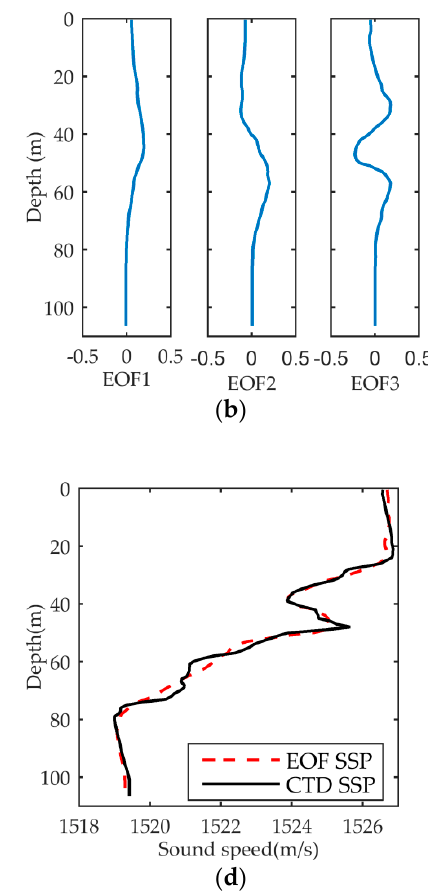
Figure 1. Empirical orthogonal function (EOF) representation of the sound speed profile (SSP). ( a ) the perturbation of SSPs measured in the 2001 Asian Seas International Acoustics Experiment (ASIAEX), East China Sea (ECS) experiment, ( b ) first three EOFs, ( c ) percentage of energy fluctuation for the first ten EOFs, and ( d ) the measured SSP (solid line) by conductivity–temperature–depth (CTD) and the inverted SSP by EOF (dashed line).